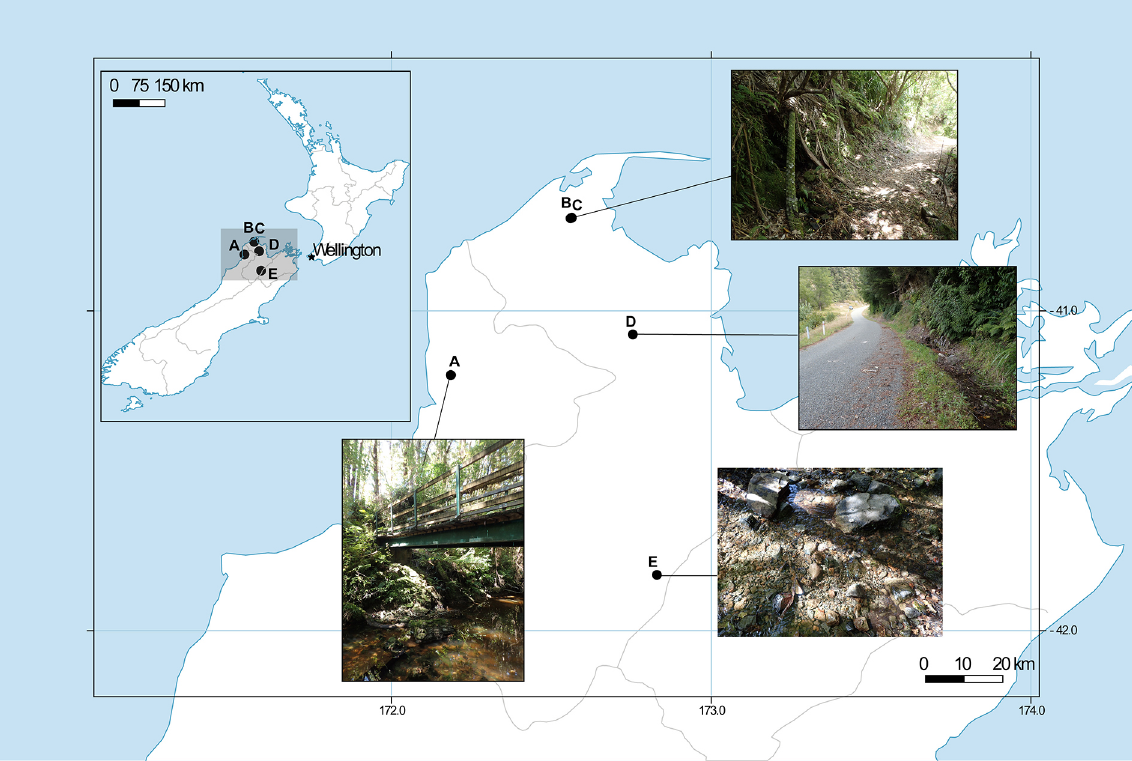
Fig. 1. Localities. A . Type locality of Opacuincola mete kahurangi subsp. nov. B . Type locality (photograph) of Catapyrgus jami sp. nov. and Op. lisannea sp. nov. C . Northern locality of Op. lisannea sp. nov. D . Type locality of Op. gretathunbergae sp. nov. E . Type locality of Obtusopyrgus farri sp. nov. For details see descriptions in